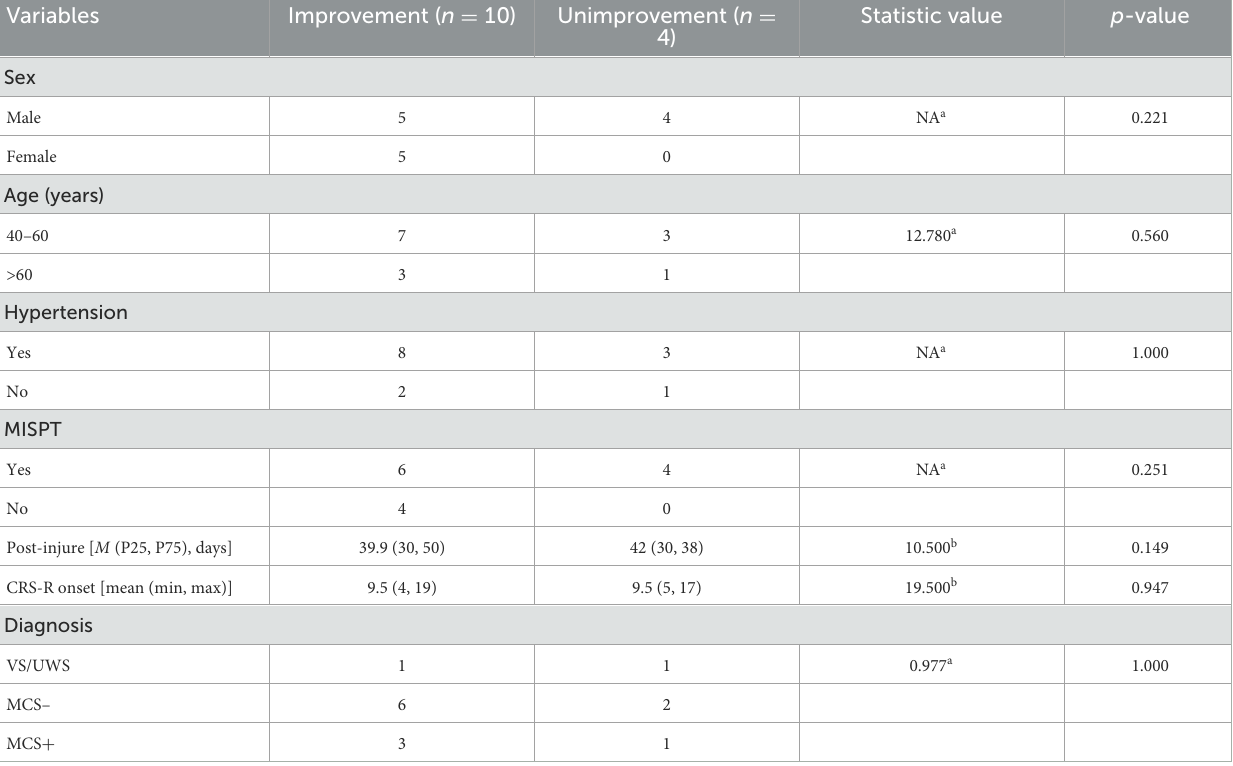
TABLE 5 Clinical variable comparisons between improvement and